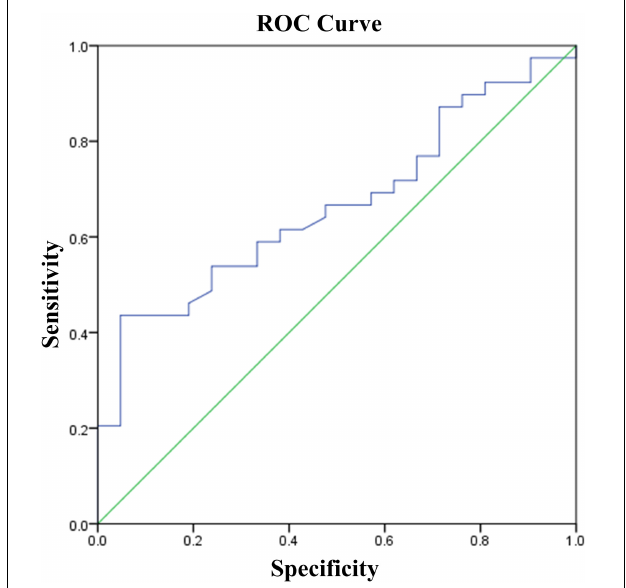
FIGURE 2 | Prediction model of treatment effectiveness of